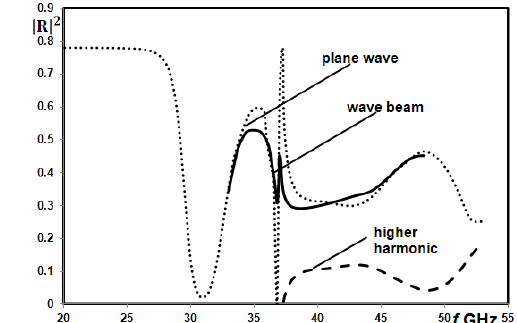
Figure 3: The comparison of the frequency dependences of the reflection coefficient intensity for the plane wave and Gaussian